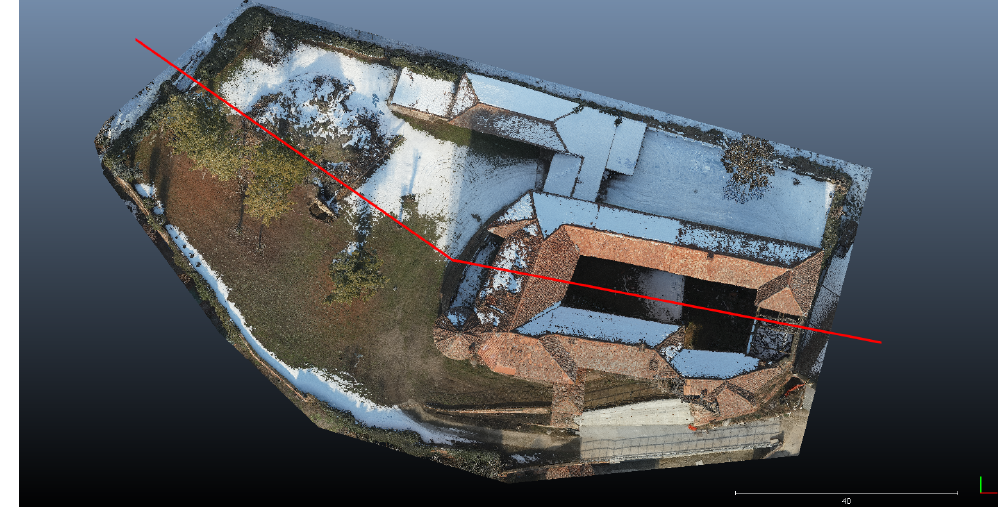
Figure 15. Extracted custom Profile 1: from east to west, passing through the courtyard.